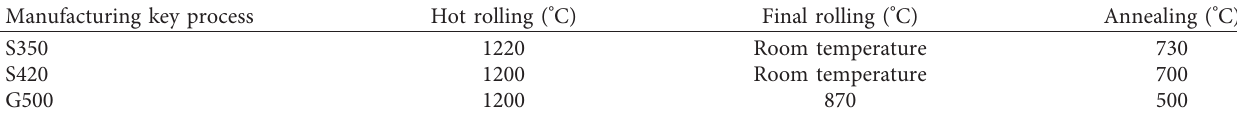
Table 2: Manufacturing key temperatures of S350, S420, and G500 steels.